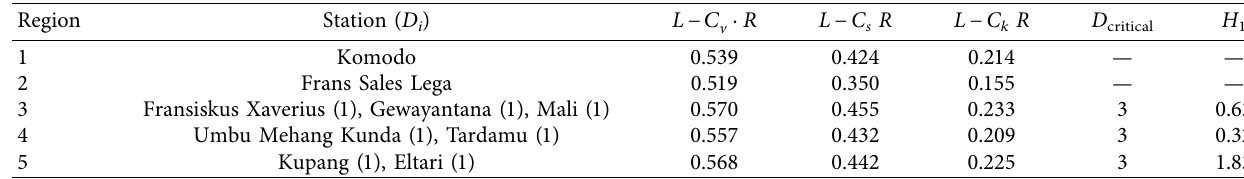
Table 3: Estimated L -moment ratio, discordancy, and heterogeneity statistic for the daily rainfall average in the five homogeneous regions.